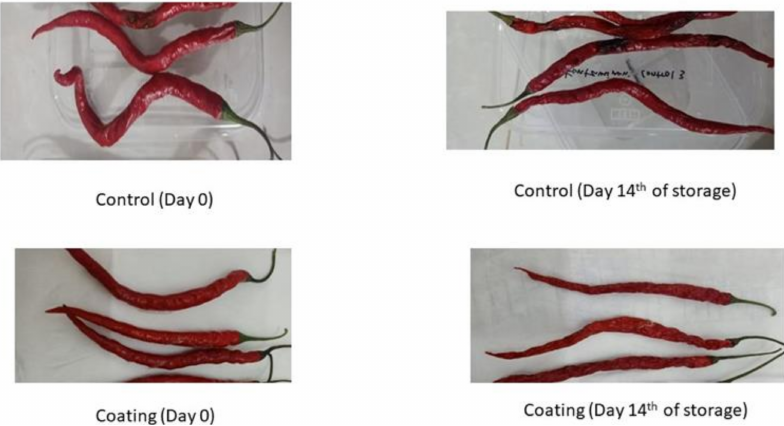
Figure 8. Appearance of Red